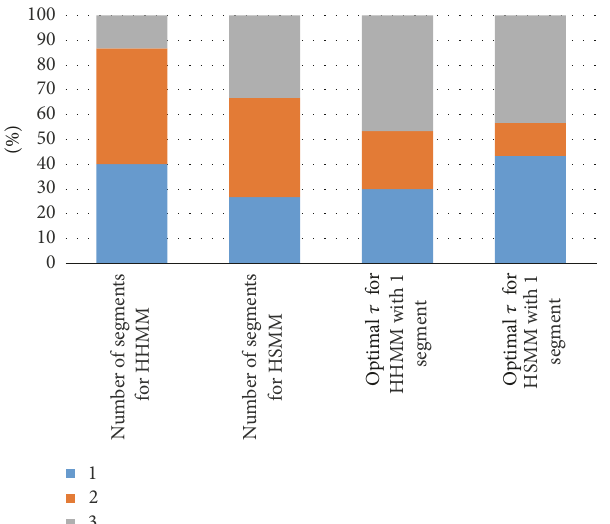
Figure 11: Optimization of the parameters. The chart shows that there is no clear advantage of using high number of segments per movement as in lot of cases even one segment is enough to achieve the highest classification accuracy. The same conclusion could be made for the number of AR samples as having only one previous sample available for making prediction could lead to high accuracy.